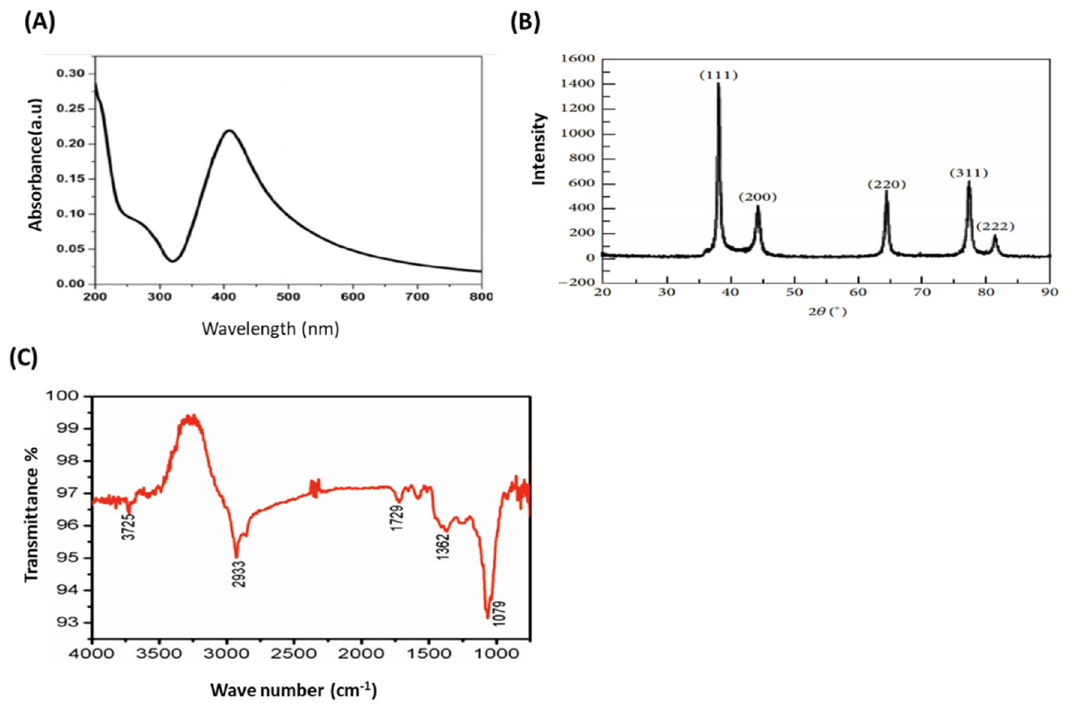
Figure 2. Confirmation of biosynthesized AS-AgNPs. ( A ) UV–VIS spectrum of AS-AgNPs. The highest absorbance peak was at about 450 nm, corresponding to the plasmon resonance of AS-AgNPs. ( B ) The XRD spectrum recorded for AS-AgNPs showed four distinct diffraction peaks 38.25 ◦ , 46.37 ◦ , 64.60 ◦ , and 77.62 ◦ corresponding to 1 1 1, 2 0 0, 2 2 0, and 3 1 1 planes for silver, respectively. ( C ) FTIR spectrum of AS-AgNPs. The peak at 3725 cm − 1 confirms strong, broad O–H stretches of carboxylic bands. The peak at 1079 cm − 1 demonstrates carbonyl stretching bands. The peak at 1362 cm − 1 specifies alkene groups. The peaks at 1729 cm − 1 and 2933 cm − 1 specify the presence of alkane groups.